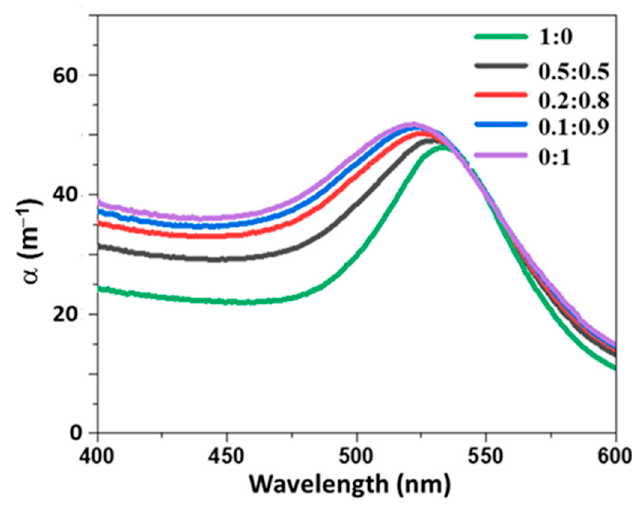
Figure 7. Measured extinction spectra of mixtures of P1 and P2 suspensions. Five volume ratios of P1 to P2 are considered.